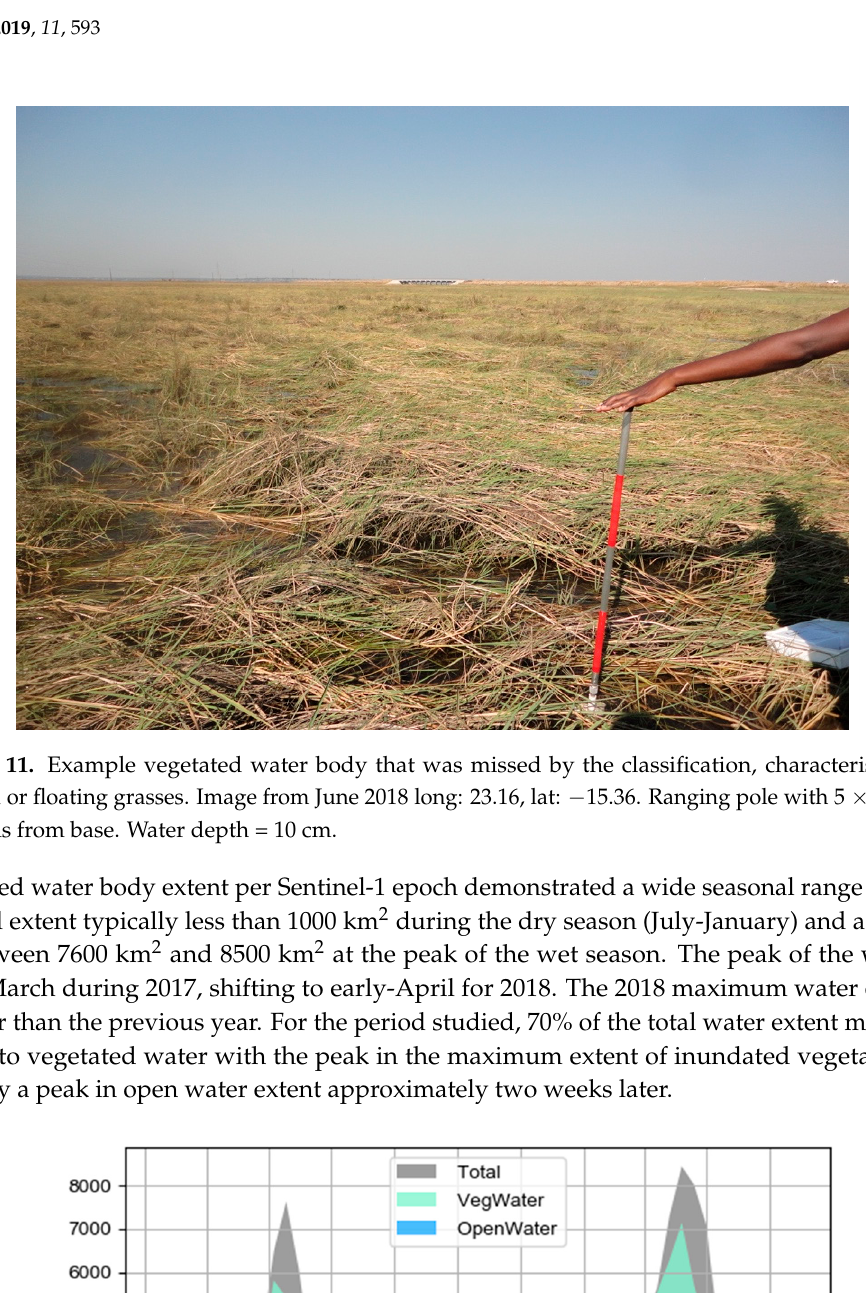
Figure 10. Example vegetated water body that was missed by the classification, characterised by dense grasses. Image from June 2018 long: 23.4, lat: -14.8. Ranging pole with 5 × 20 cm sections from base. Water depth = 40 cm.